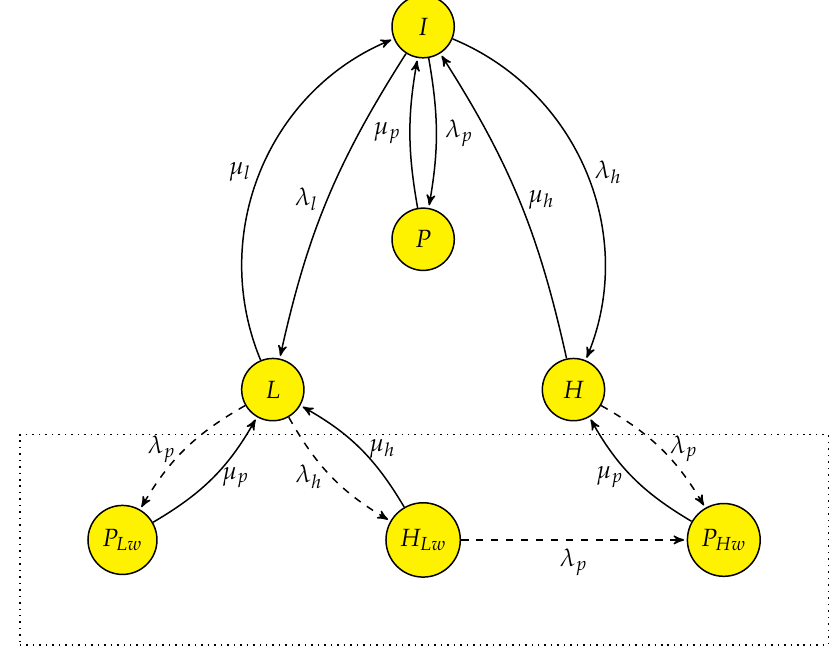
Figure 7. State transition diagram of PN-MC-IW, “- - - >” indicates spectrum handoff event. State P Lw is achieved when a SU lp is interrupted by a PU, which forces it to perform a non-switching handoff. Once PU departs with rate µ p the SU lp becomes active and resumes its transmission on the same channel and departs with rate µ l . Similarly when SU hp is preempted by PU, state transits from H to P Hw